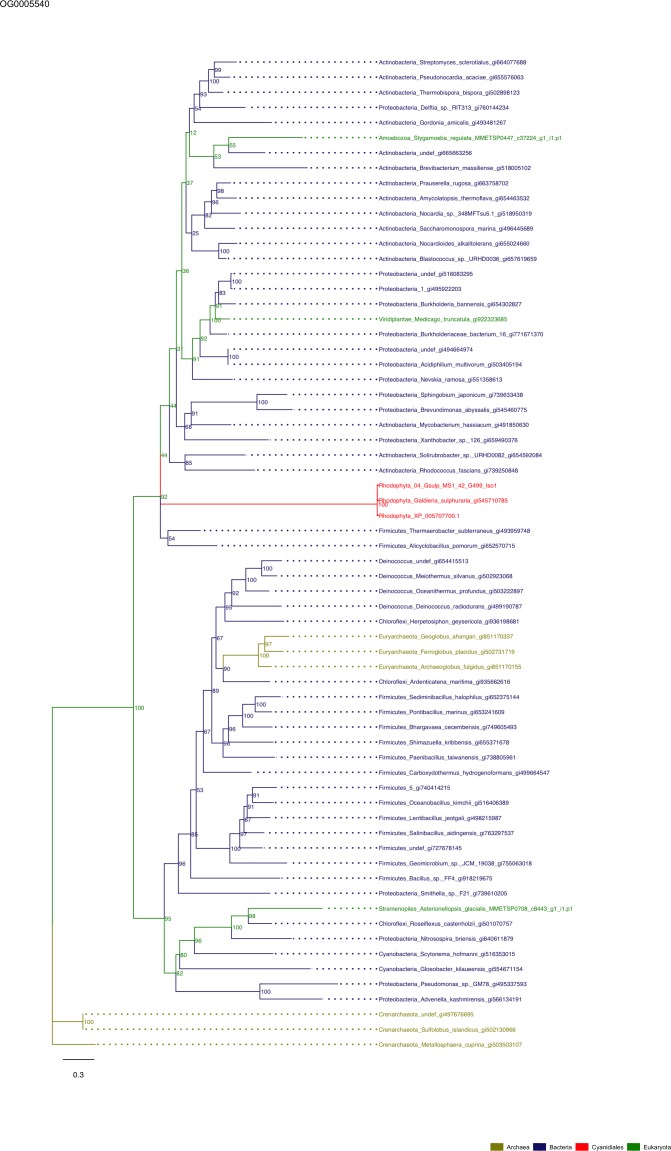
Sequence tree of orthogroup OG0005540.The tree is based on amino acid sequences. Archaea (yellow), Bacteria (blue), Cyanidiales (red), Eukaryotes including other red algae (green). Branches containing Cyanidiales sequences are highlited in red.